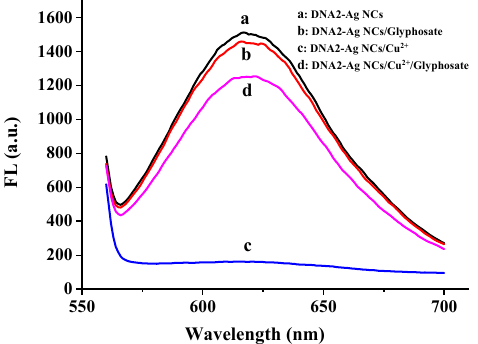
Figure 7. Fluorescence spectrum of DNA2-Ag NCs (a), DNA2-Ag NCs/glyphosate (b), DNA2-Ag NCs/Cu 2+ (c), and DNA2-Ag NCs/Cu 2+ /glyphosate (d).